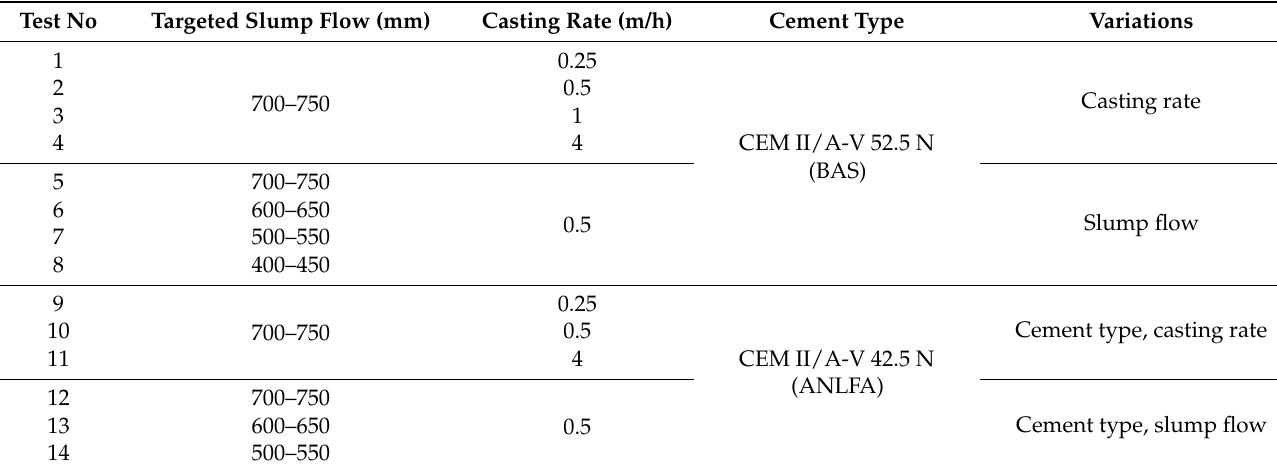
Table 2. Test plan and parameter